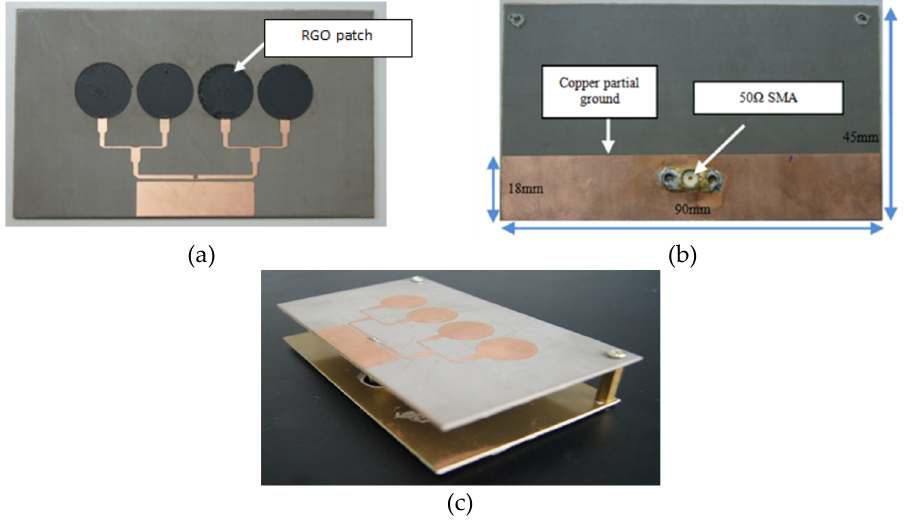
Figure 7. Fabricated sensor views; ( a ) front, ( b ) back, ( c ) side.